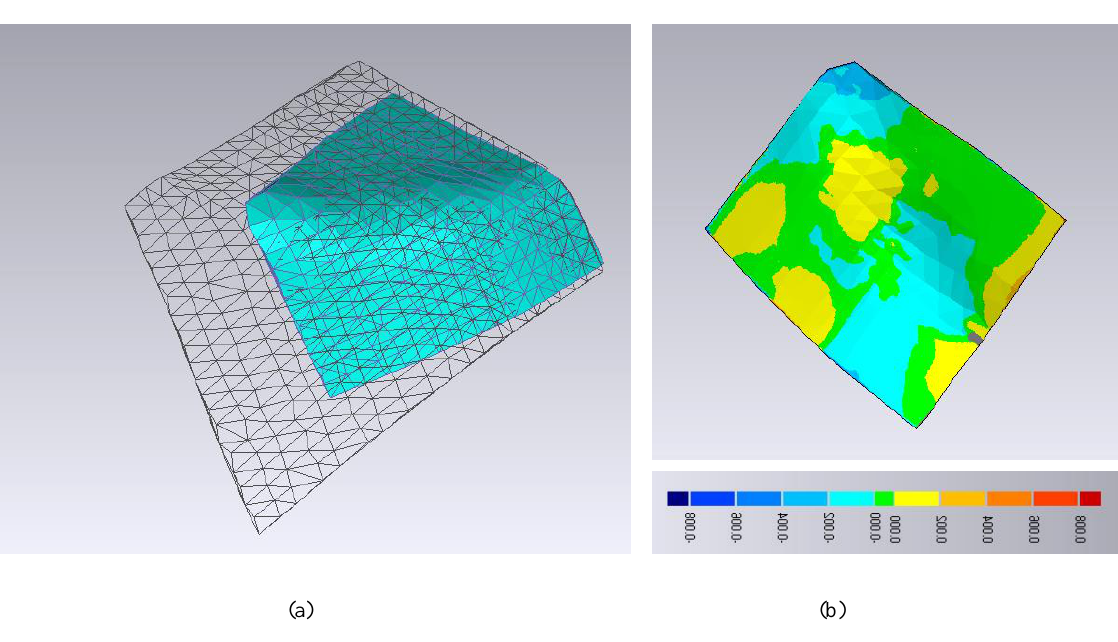
Figure 4. (a) is the registration with TLS ans (b) shows the